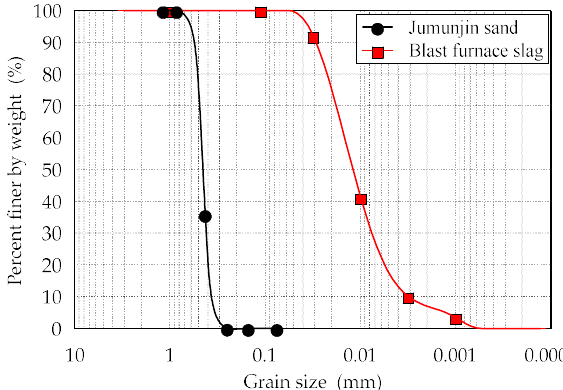
Figure 1. Grain size distribution curves of Jumunjin sand and blast furnace slag (BFS). Table 1. Physical properties of Jumunjin sand and BFS.